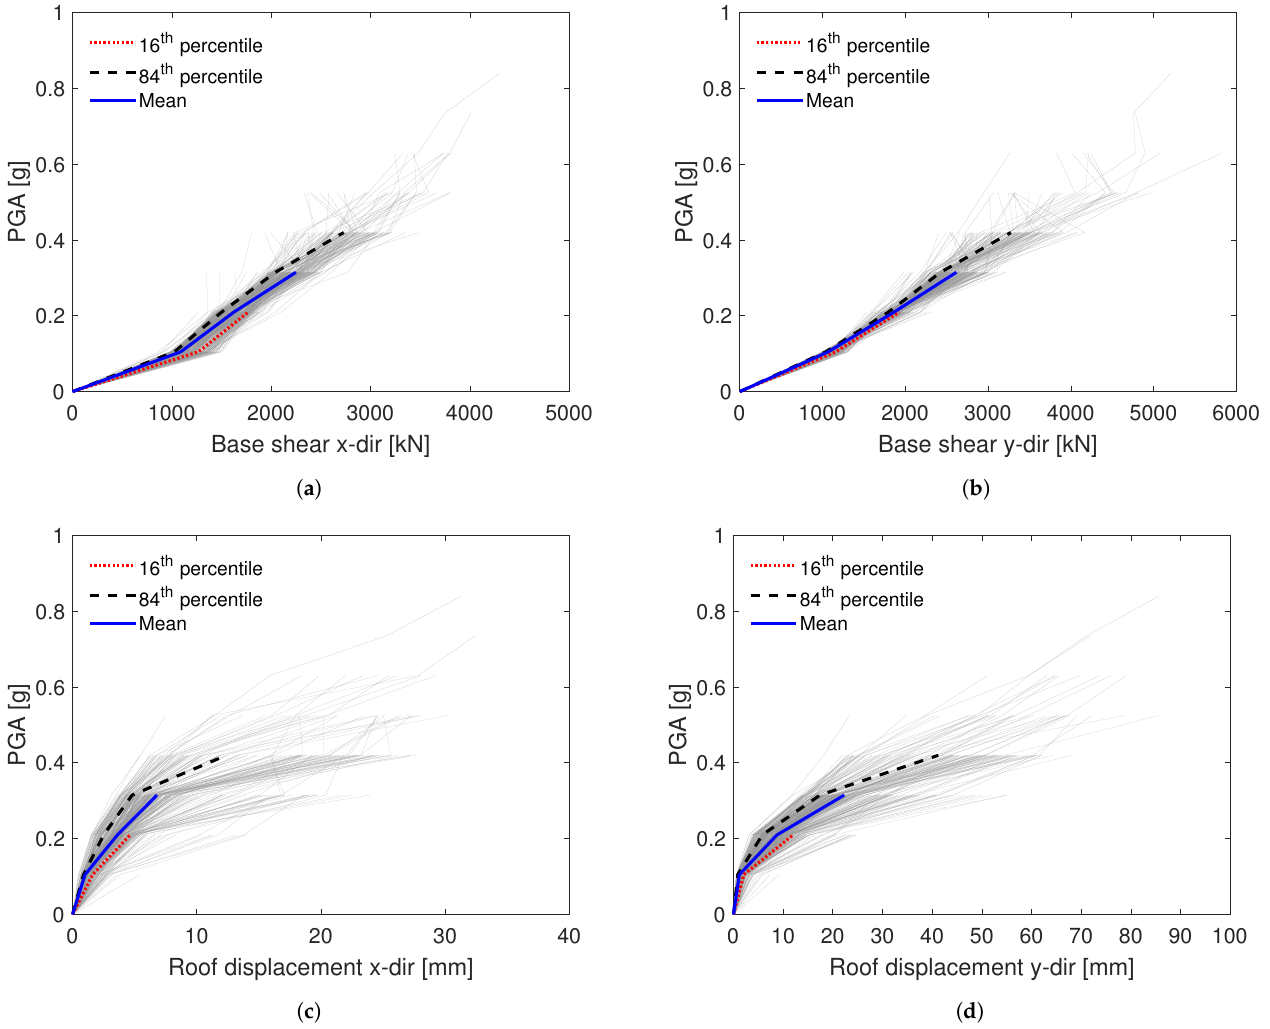
Figure 8. IDA curves for the Holsteiner Hof model for various seismic demand parameters: ( a ) Total base shear in x- direction. ( b ) Total base shear in y-direction. ( c ) Average roof displacement in x-direction. ( d ) Average roof displacement in